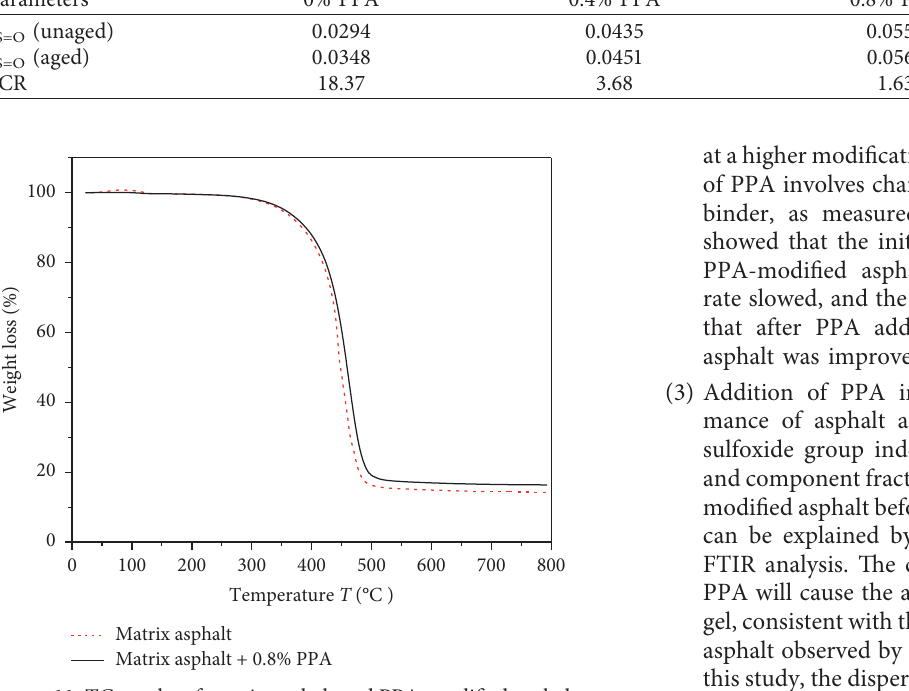
Table 5: Sulfoxide index and sulfoxide index change rate of modified asphalt with different PPA content before and after TFOT aging. Parameters